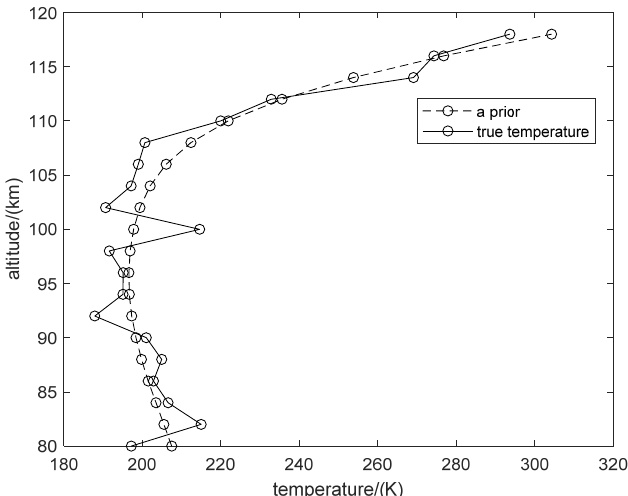
Figure 7. Comparison of a priori information and actual temperature information.